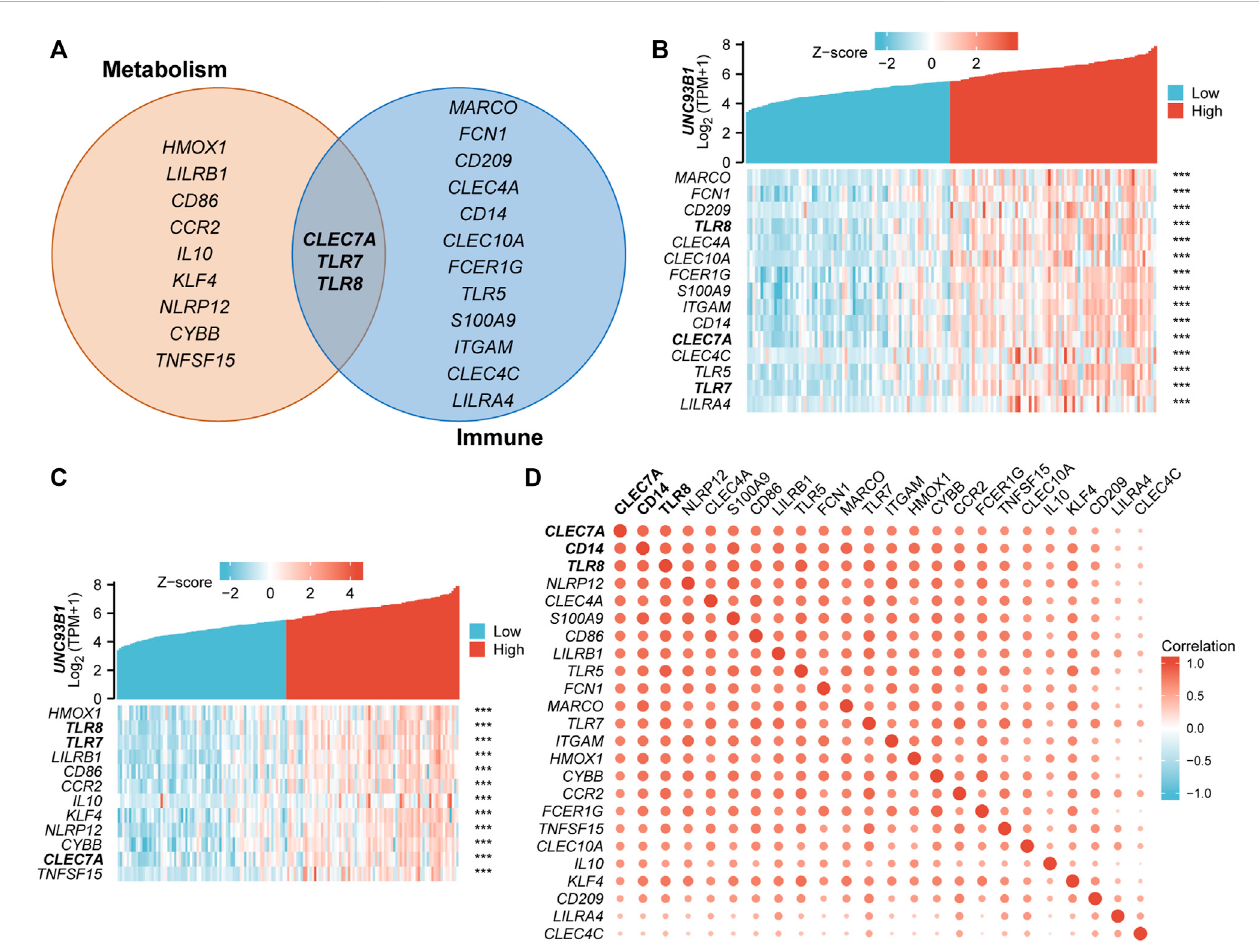
FIGURE 6 Association of UNC93B1 with innate immune and metabolic process. (A) Venn diagram of genes enriched in innate immune response-activating signal transductionpathway(right)andcytokinemetabolicprocesssignaling(left). (B) Co-expressionheatmapofUNC93B1andinnateimmuneresponse-activating signal transduction related genes. (C) Co-expression heatmap of UNC93B1 and cytokine metabolic process related genes. (D) Positive correlation of genes ’ expression corresponding to innate immune response-activating signal transduction and cytokine metabolic